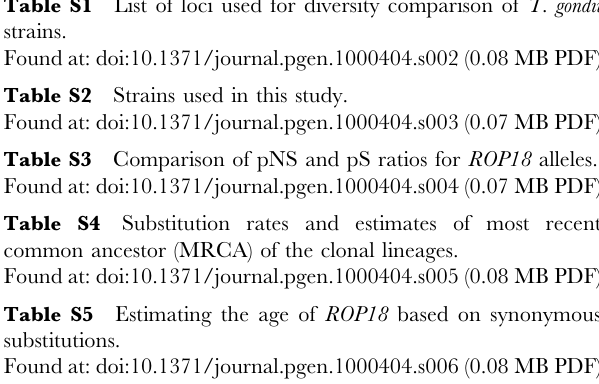
Figure S1 Distribution of SNPs surrounding ROP18 . Elevated levels of type III-specific single nucleotide polymorphisms (SNPs) occur within a 30 kb region of ROP18 . A) Screen capture of the Genome browser view of ROP18 (20.03896) and flanking regions from position 1449000 to 1489000 bp on chromosome VIIa (http://www.toxodb.org/). Annotated genes are shown in colored rectangles with corresponding gene ids. SNPs were identified by NUCmer alignments of GT1 (type I) and VEG (type III) to ME49 (type II) whole genome sequences and corresponding predicted coding regions. Red, green and blue color diamonds indicate the type I, II, and III specific SNPs, respectively. B) Graphical representation of type I (red), II (green), and III (blue) specific SNPs (in 1 kb windows) present on 40 kb region surrounding the ROP18 gene. Type III-specific SNPs are elevated throughout but show a strong peak for ROP18 . Table S1 List of loci used for diversity comparison of T. gondii strains. Table S2 Strains used in this study. Table S3 Comparison of pNS and pS ratios for ROP18 alleles. Table S4 Substitution rates and estimates of most recent common ancestor (MRCA) of the clonal lineages. Table S5 Estimating the age of ROP18 based on synonymous